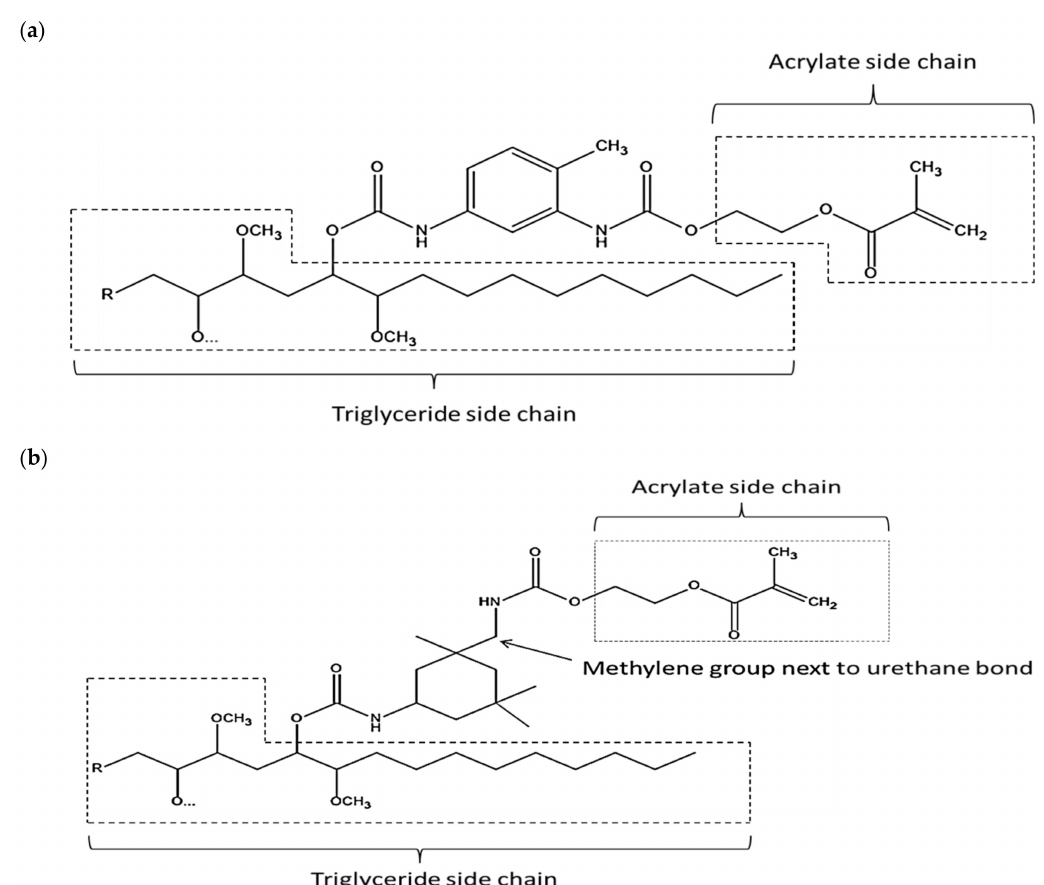
Figure 4. Details of side chain on ( a ) JPUA-TDI and ( b ) JPUA-IPDI